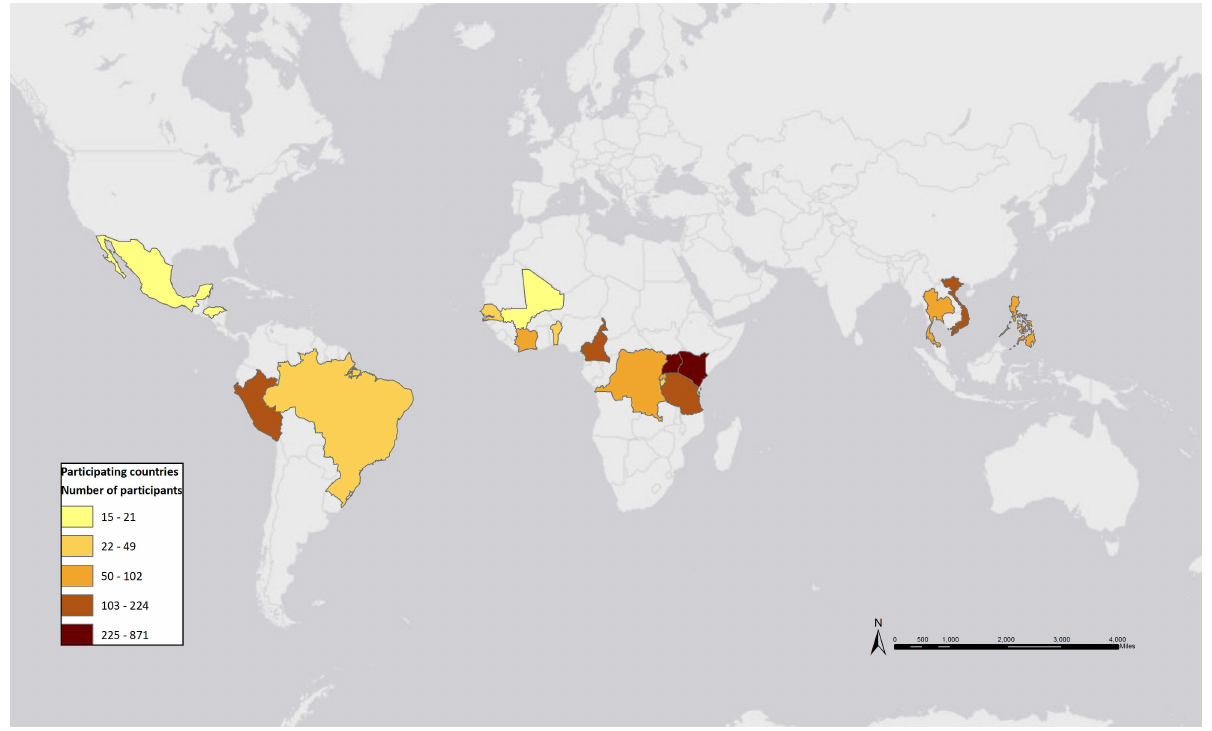
Fig 1. Participating countries (n = 18) and number of patients included by each. Map created in July 2016 by Kate Clouseusing ArcMap GIS 10.3.1 (Esri, Redlands, CA).